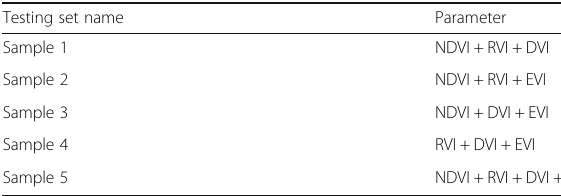
Table 1 Different combination of characteristics